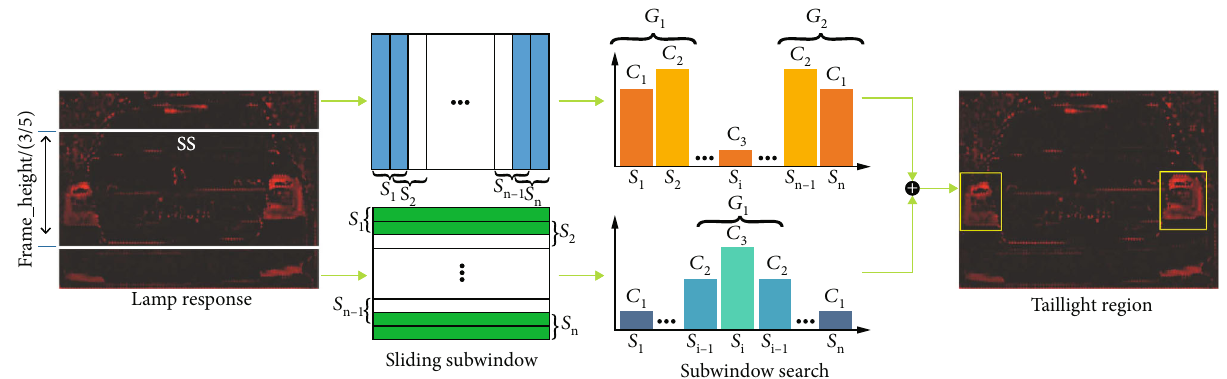
Figure 6: Overview of the proposed subwindow search method. First, we narrow down the searching space (SS) of the taillight position to the middle three- fi fths area of an APS frame. Then, candidate subwindows S are generated with overlapping blocks in each dimension of SS through a sliding window algorithm. Second, we aggregate the subwindows in each direction into k subwindow clusters. Furthermore, we remove these subwindows in the lowest cluster to fi lter out background interference and merge the adjacent subwindows in the rest into a group G j . Finally, an IOU searching operation is followed to fi nd the taillight position. Considering that vehicle taillights are usually located at the left-hand and right-hand sides of the vehicle, the largest group region in the vertical direction is searched, and the fi rst two largest group regions in the horizontal direction are